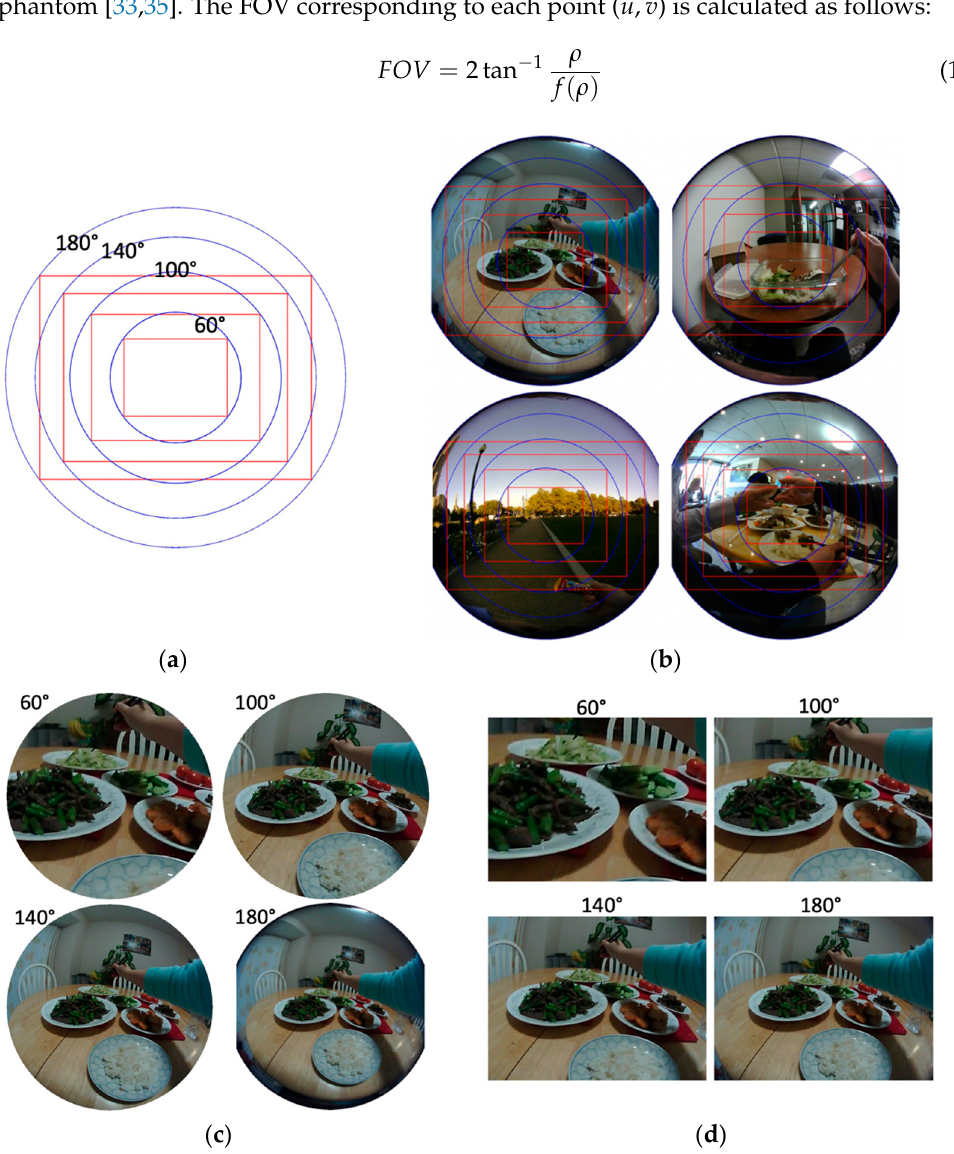
Figure 8. ( a ) Circular (blue) and rectangular (red, 4:3 screen ratio) image domains of different FOVs. ( b ) Real-world food-containing circular images acquired using our DA wearable (eButton) with a Type M7-1-08-Y fisheye lens. ( c , d ) Effects of circular and rectangular images corresponding to the FOVs in ( a ).